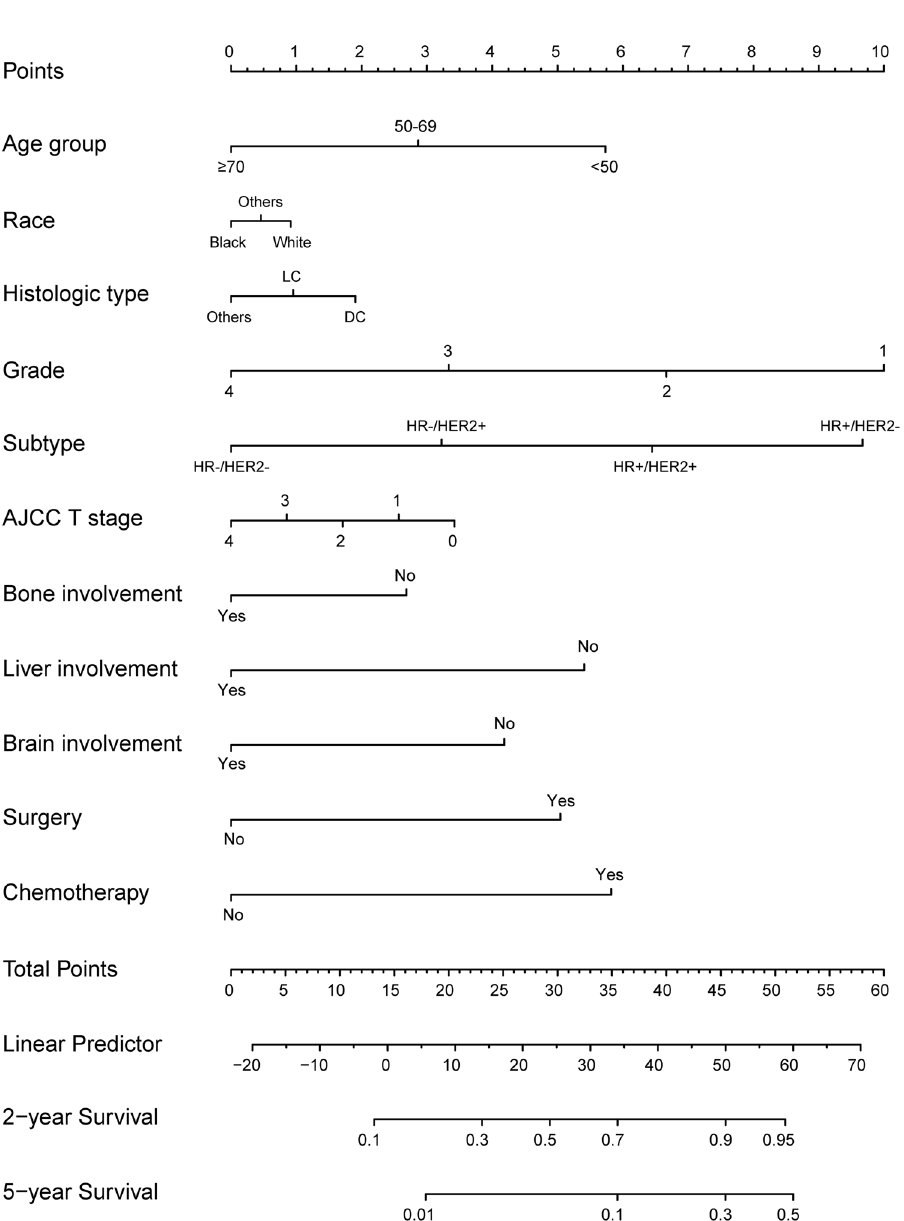
Figure 2. Nomogram for individual estimation of 2- and 5-year survival probabilities in LMBC patients. (R software version 3.6.4, www.r- proje ct.